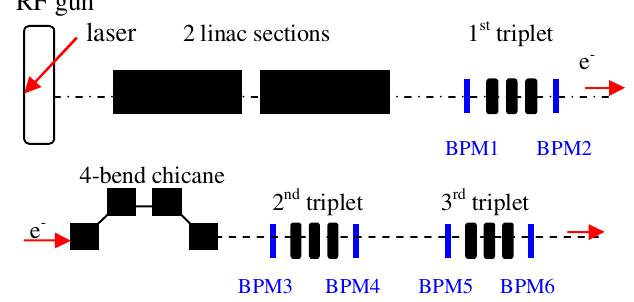
FIG. 1. (Color) Schematic layout of the ATF H-line; the beam bends in the vertical ( y ) plane in the chicane.